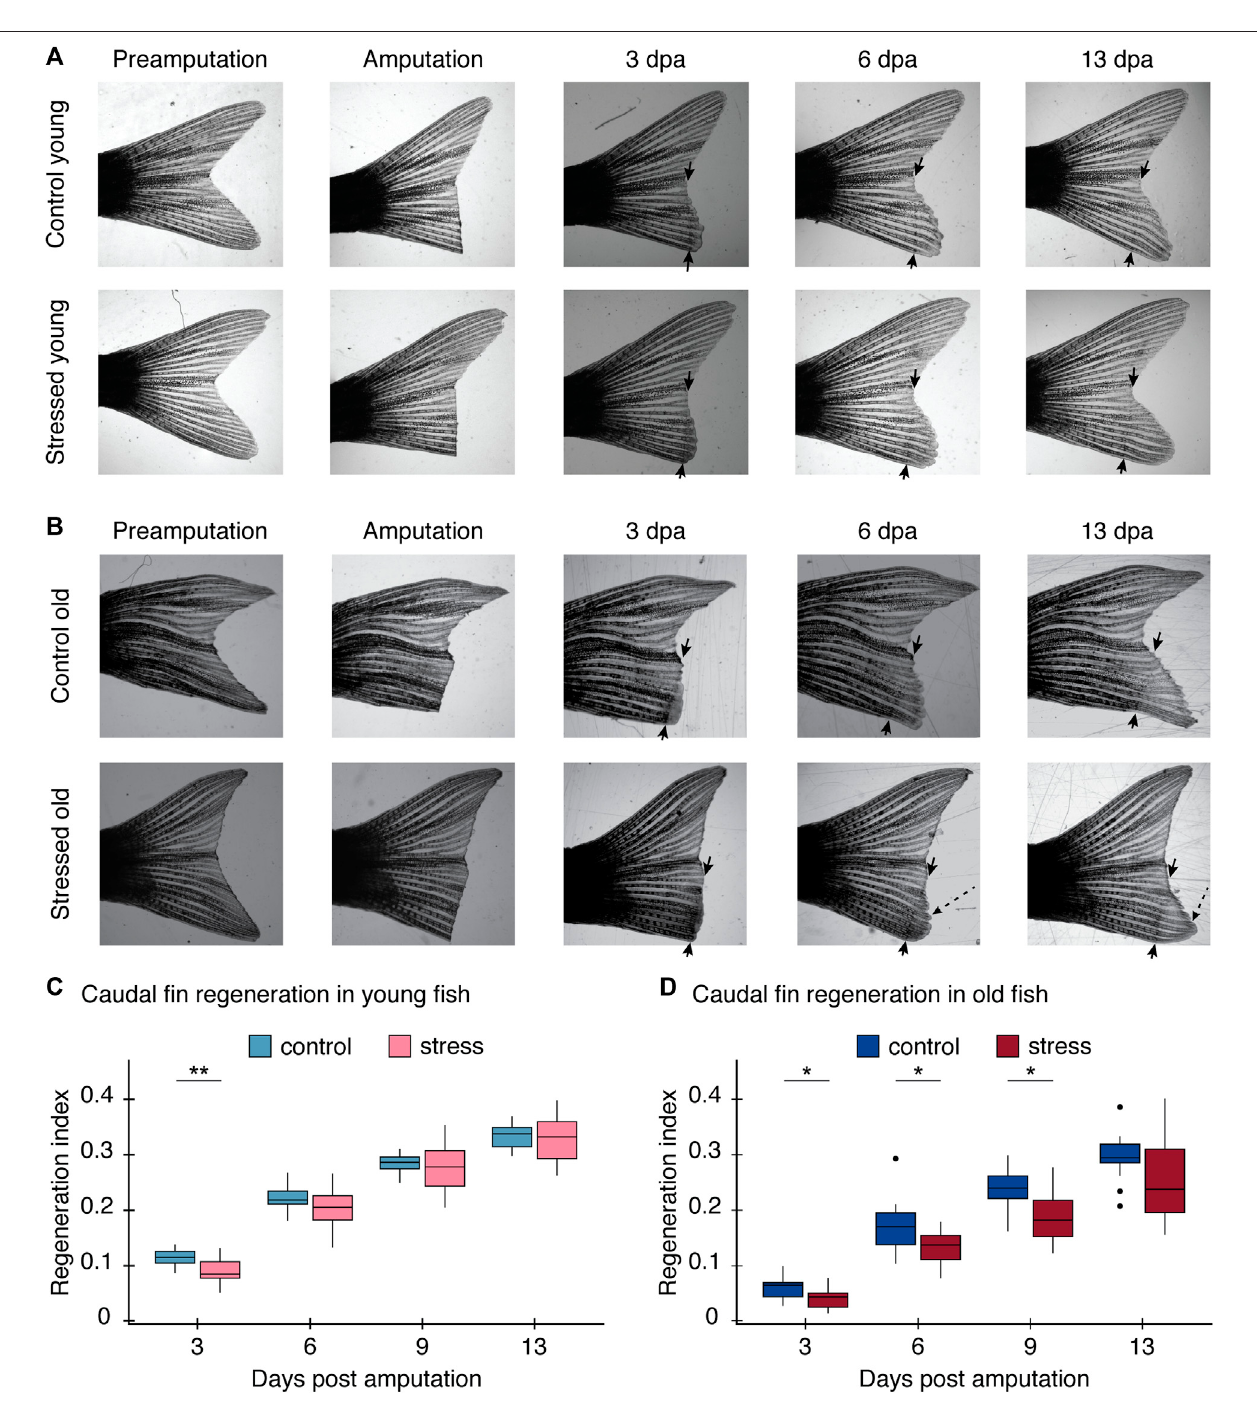
FIGURE3| Regenerationprocessafterthestressprotocol.Theregenerationindexiscalculatedasthelengthoftheregeneratedtissue/initiallengthofthecaudal fi n of each fi sh measured from the most proximal part of the lepidotrichia. (A) Images of caudal fi n growth measurements after amputation for young control fi sh (top row) and young stressed fi sh (bottom row). (B) Images of caudal fi n growth measurements after amputation for old control fi sh (top row) and old stressed fi sh (bottom row). Black arrows indicate the amputation site. An additional measurement was done at 9 dpa but the image was excluded for clarity; complete regeneration process shown in Supplementary Figure S2 for young and Supplementary Figure S3 for old fi sh. Note heterogeneous growth in old fi sh (dashed line arrow). Further results ontheseunusualgrowthpatterncanbeseenin SupplementaryFigureS4 . (C) Graphcomparingtheregenerationindexofthecontrolandstressyoungcaudal fi nat3, 6,9,and13 dpa;twocohortsincludedinthisexperiment. (D) Graphcomparingtheregenerationindexofthecontrolandstressoldcaudal fi nat3,6,9,and13 dpa;two cohorts included in this experiment. All results are expressed as the mean ± standard error of mean (S.E.M). * p < 0.05; ** p < 0.01; *** p < 0.001.